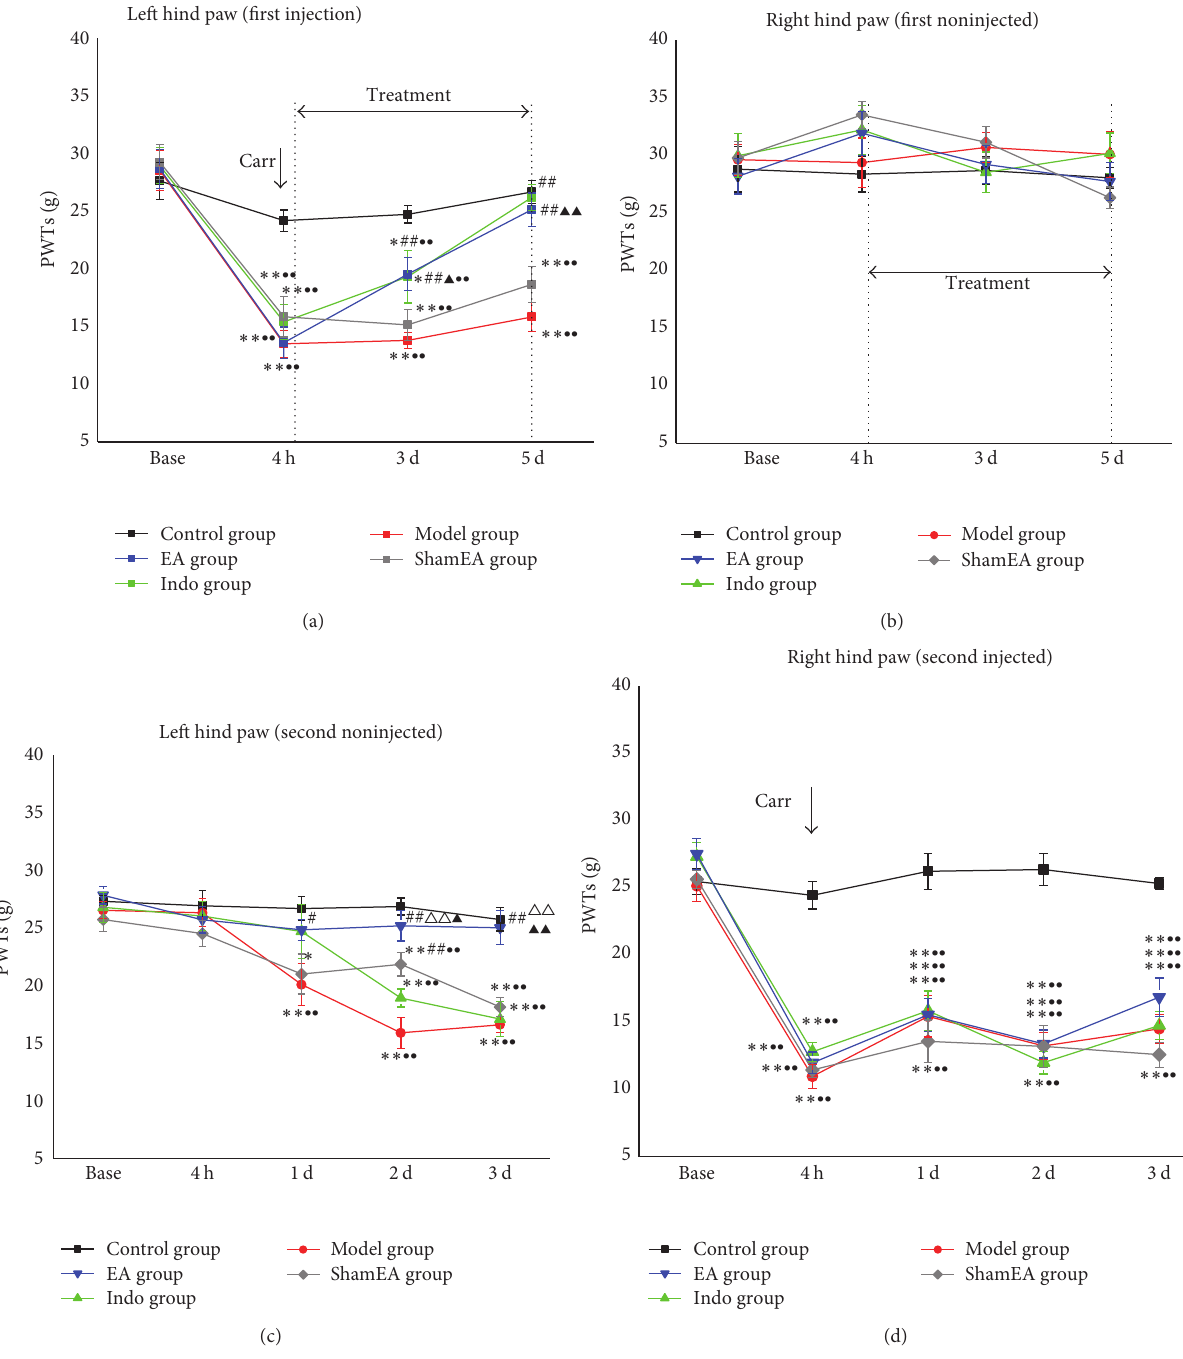
Figure 3: EA alleviated the retrieval of pain memory. The rats in the pain memory model were divided into the control, model, indo, EA, and sham EA groups, and the mechanical allodynia in each group was examined ( 𝑛 = 10 ). (a) On the left hind paw (first injected), EA or indomethacin treatment increased the PWTs significantly compared with the model group. (b) There was no significant difference in all groups at the same period. (c) On the left hind paw (second noninjected), the PWTs in the model group decreased significantly compared with the control group and its baseline. EA treatment administered at the first injection time point inhibited this progress. (d) The second injection of carrageenan into the right hind paw significantly decreased the PWTs of the carrageenan-injected groups compared with the control group and their baselines. Error bars indicate the SEM. ∗ 𝑝 < 0.05 and ∗∗ 𝑝 < 0.01 , versus the control group; # 𝑝 < 0.05 and ## 𝑝 < 0.01 , versus the model group; △△ 𝑝 < 0.01 , versus the indo group; 󳵳 𝑝 < 0.05 and 󳵳󳵳 𝑝 < 0.01 , versus the sham EA group; ee 𝑝 < 0.01 , versus